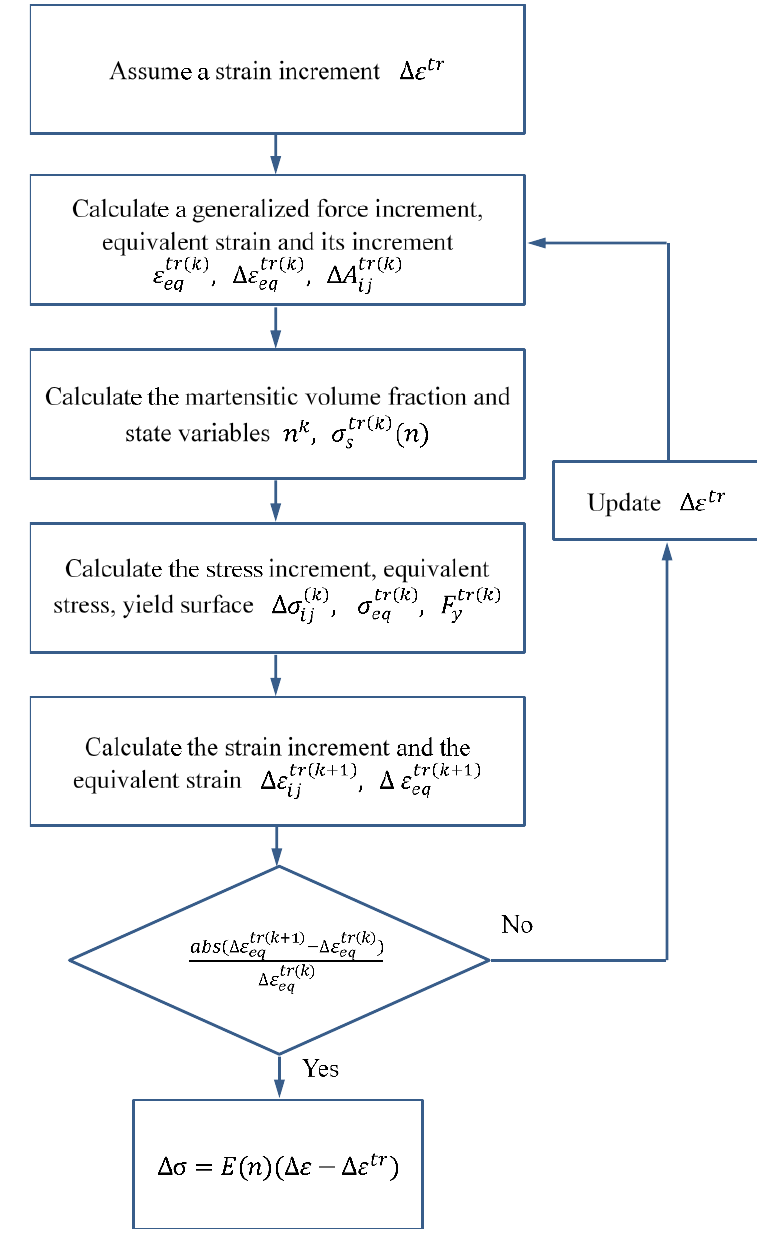
Figure 2. Flow chart of the solution of phase transition stage.